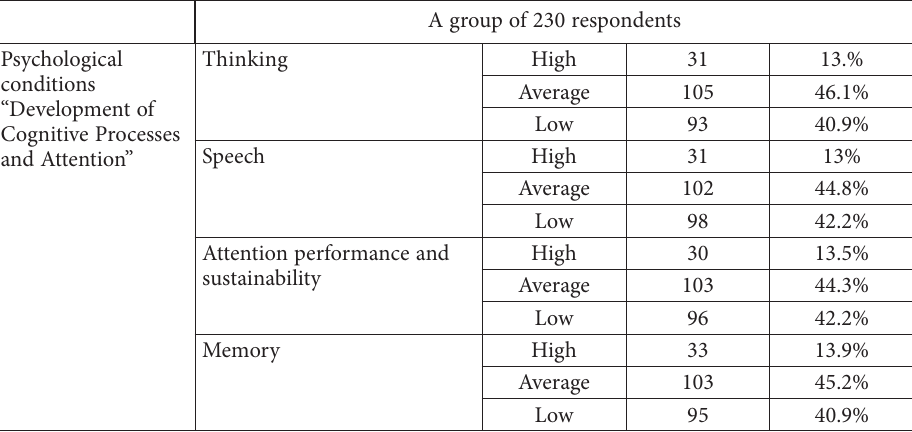
Table 1. Quantitative characteristics of empirical results of diagnostic tools in children A group of 230